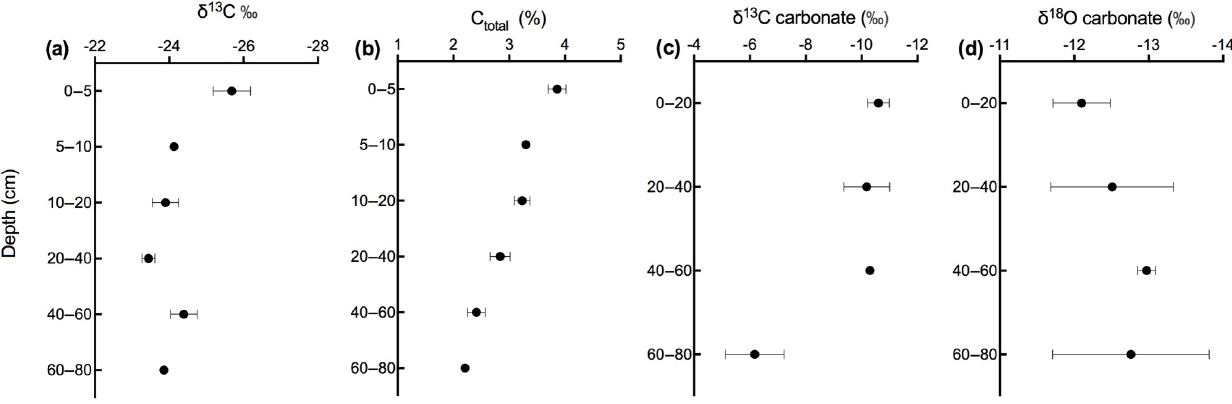
Figure 8. Depth profile of (a) δ 13 C, (b) carbon content, (c) δ 13 C of soil carbonate, and (d) δ 18 O of soil carbonate in calcareous